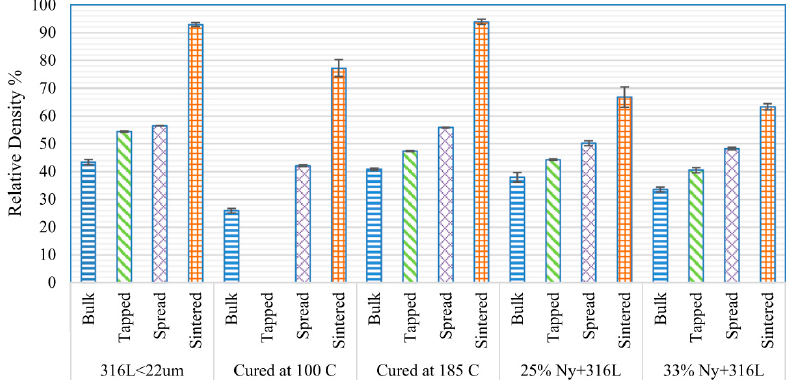
Figure 15. Relative bulk, tapped, and spread densities for the raw 316 and processed powders [106].